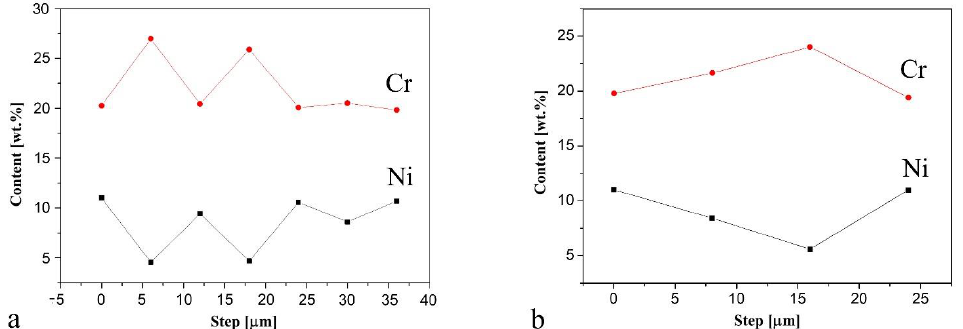
Figure 9. Distribution of the alloying elements (Cr, Ni) along the EDS lines: ( a ) deposition welding without peening; ( b ) deposition welding with peening.